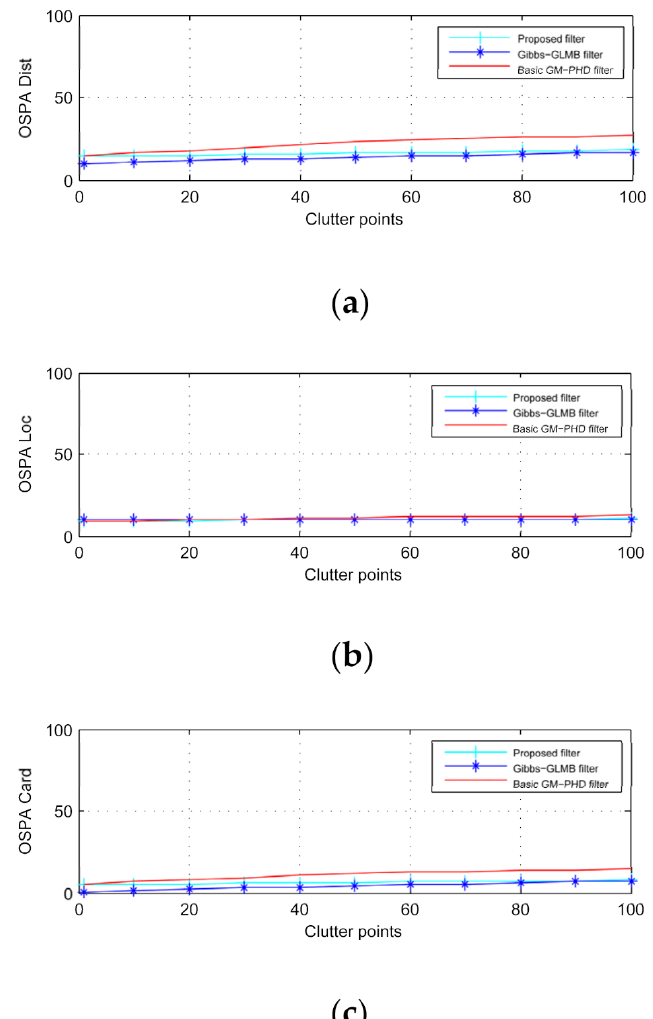
Figure 7. Comparison of different algorithms under various clutter rates for 250 sample runs ( p D , k = 0.95). ( a ) Average OSPA distances of different filters; ( b ) OSPA locations of different filters; ( c ) OSPA cardinalities of different filters.